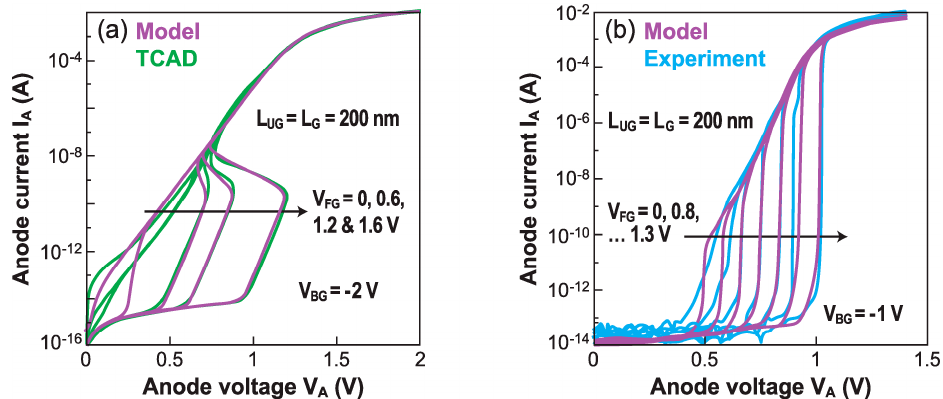
Figure 13. ( a ) Current-driven Z 2 –FET characteristics predicted by the compact model and by TCAD simulations. ( b ) Voltage-driven characteristics obtained from model and measurements (adapted from [29]).